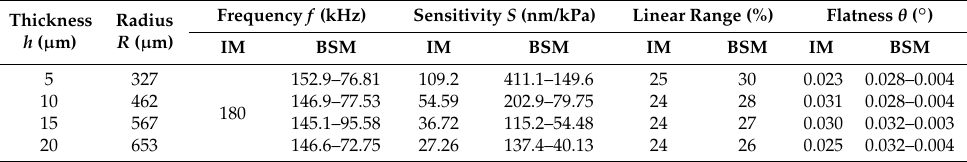
Table 1. Comparison of the realized performance for intact membrane (IM) and beam-supported membrane (BSM) structures.